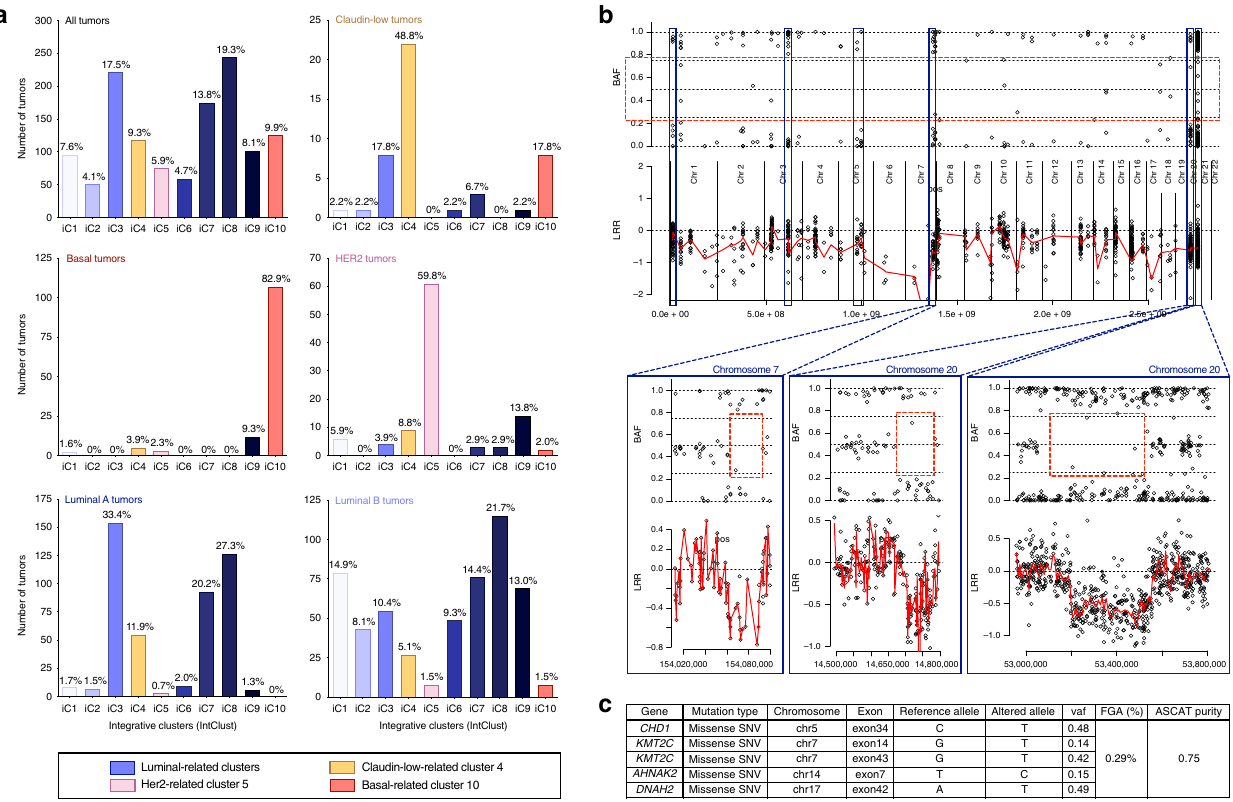
Fig. 1 Claudin-low tumors are distributed across luminal-like IntClust3, basal-like IntClust10, and CNA-devoid IntClust4, which harbors rare focal genomic alterations. a Repartition of breast tumors from the METABRIC cohort for each molecular subtype among integrative clusters. Number of tumors are represented on the y axis and the corresponding percentages are indicated above each bar. All tumors ( n = 1266); claudin-low tumors ( n = 45); basal tumors ( n = 129); HER2 tumors ( n = 102); luminal A tumors ( n = 461); luminal B tumors ( n = 429). b , c Identi fi cation of focal genomic alterations in a CNA-devoid IntClust4 claudin-low sample (MB-6052/FGA < 0.3%). b BAF and LRR plots of SNPs localized in genomic regions of copy number deletion (LRR < 0.4). c Mutation analysis from targeted sequencing data. BAF: B allele frequency; CNA: copy number alteration; FGA: fraction of genome altered; IntClust: integrative cluster; LRR: log R ratio; SNP: single-nucleotide